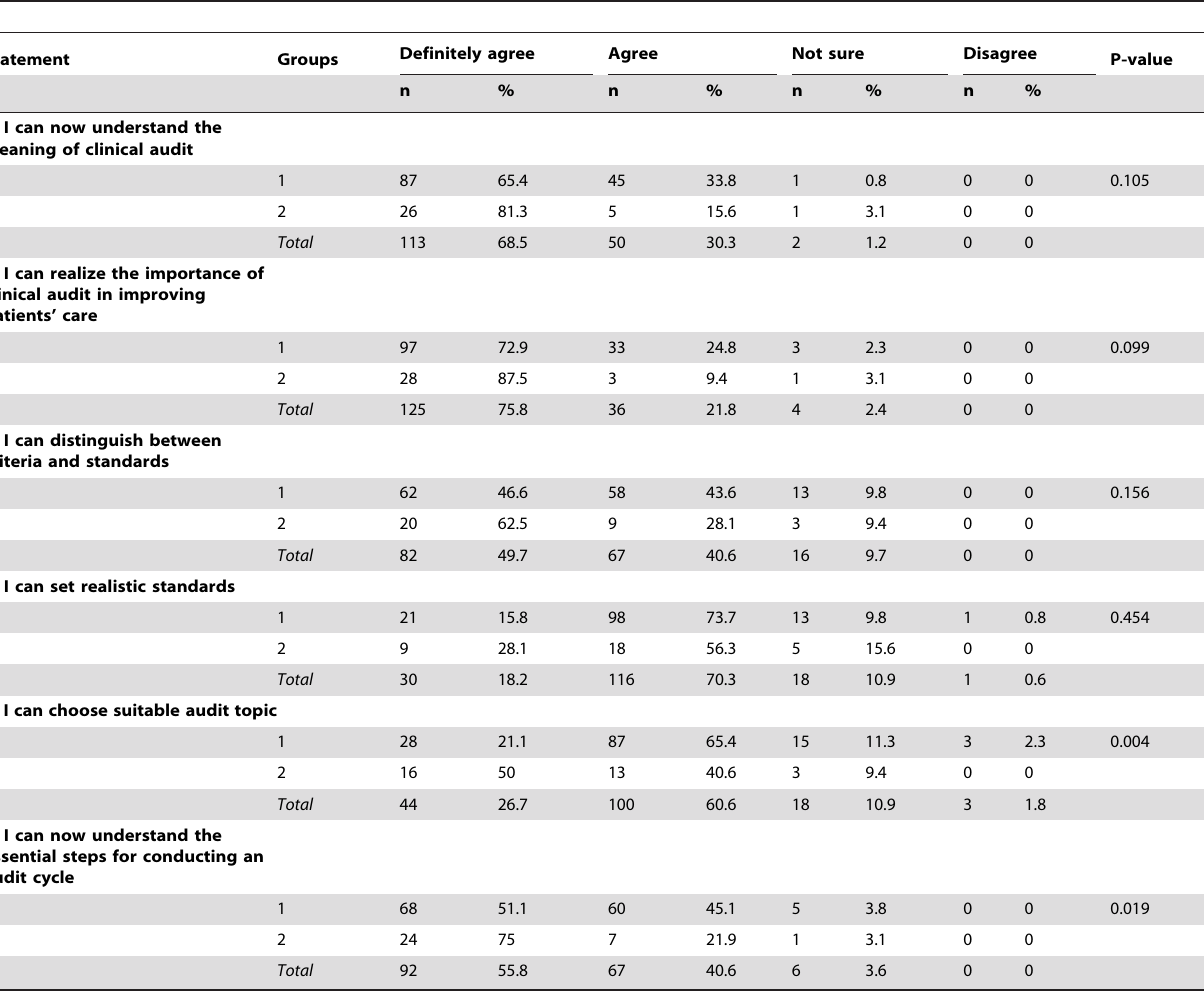
Table 4. Comparison between both groups (those who submitted and those who still haven’t submitted their audits) according to their responses for the 6 post-course